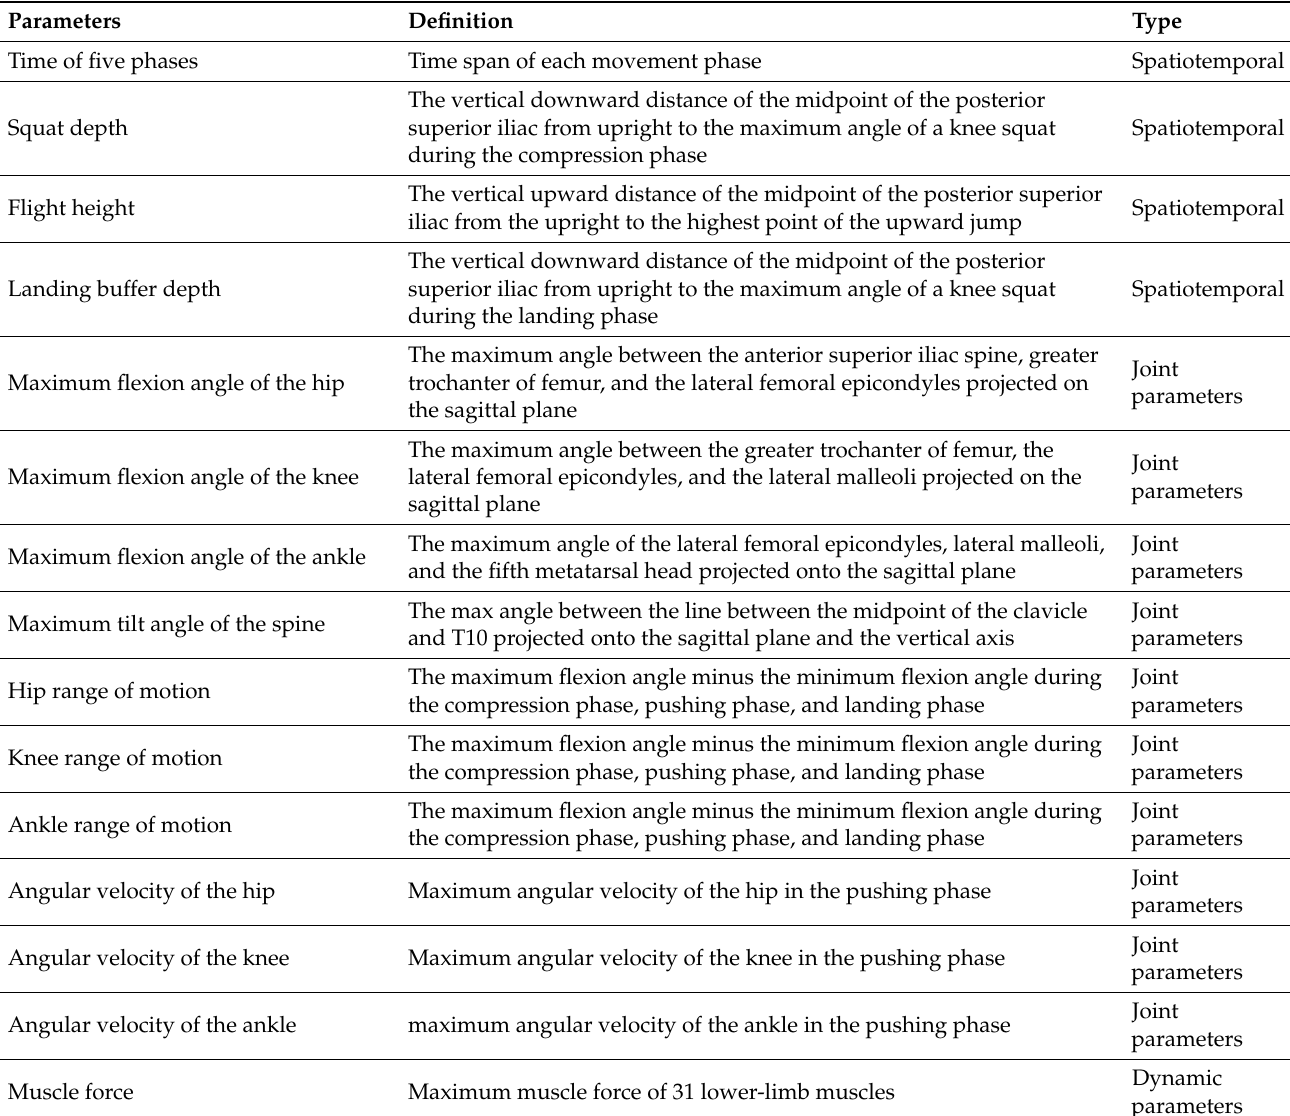
Table 2. Kinematic and dynamic parameters in vertical